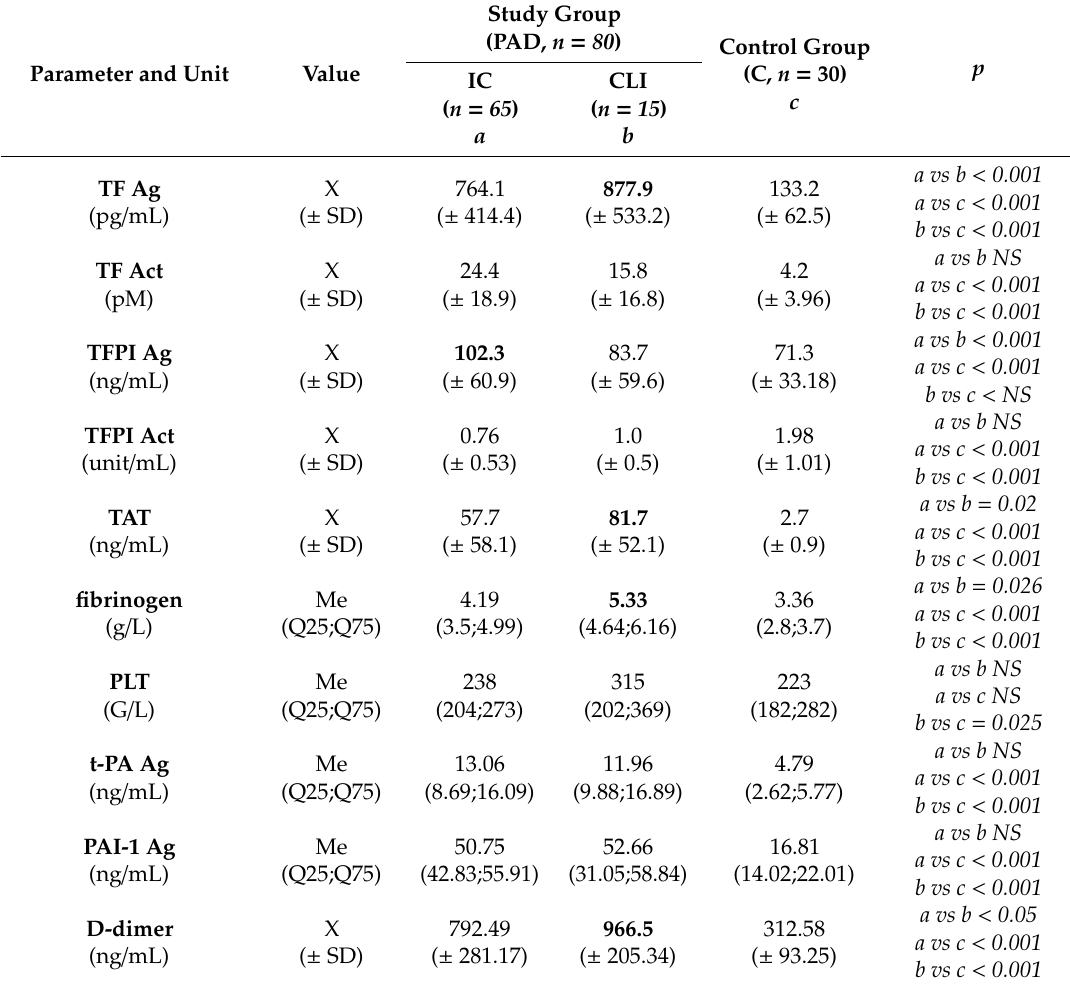
Table 2. Values of parameters analyzed in the study group within the subgroups of patients with intermittent claudication (IC) and critical limb ischemia (CLI) against the control